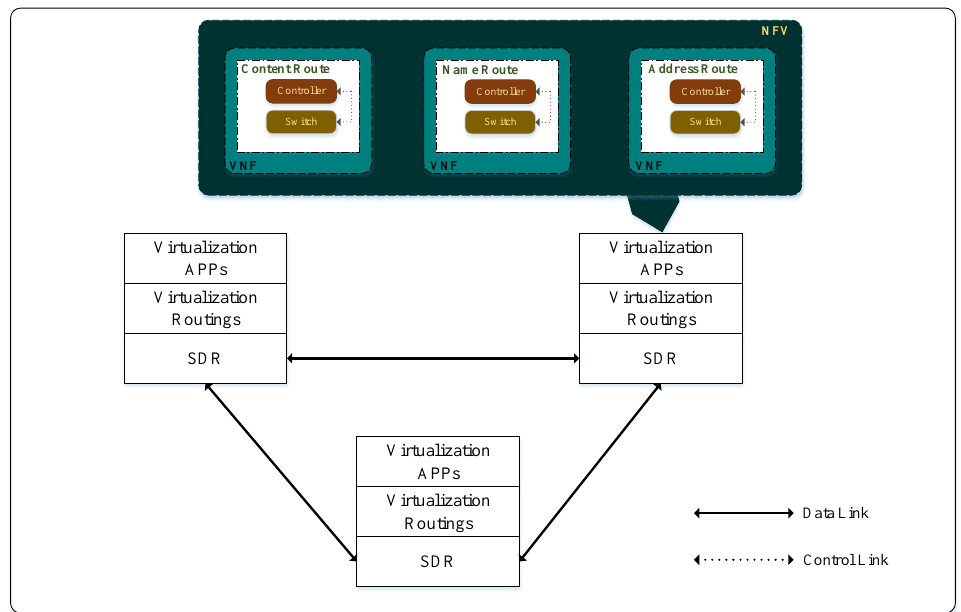
Figure 4. Implement of control forwarding of MMNET routing.